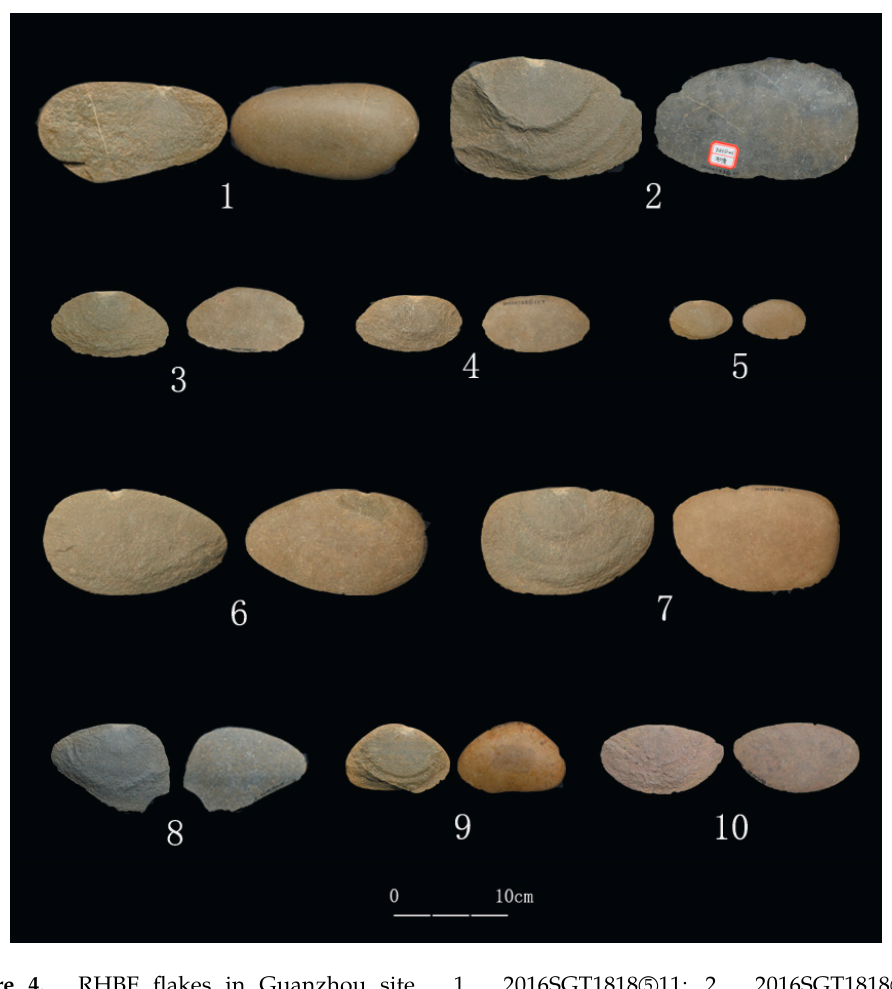
Figure 4. RHBF flakes in Guanzhou site. 1. 2016SGT1818 ⑤ 11; 2. 2016SGT1818 ⑥ 415; 3. 2016SGT1818 ⑥ 505 4. 2016SGT1818 ⑥ 657; 5. 2016SGT1818 ⑥ 751; 6. 2016SGT1819 ⑦ 82; 7. 2016SGT1919 ⑤ 7; 8.